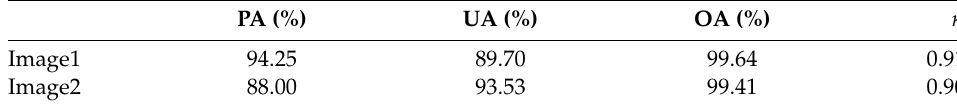
Table 4. Extraction accuracies and the kappa coefficient after NSP.